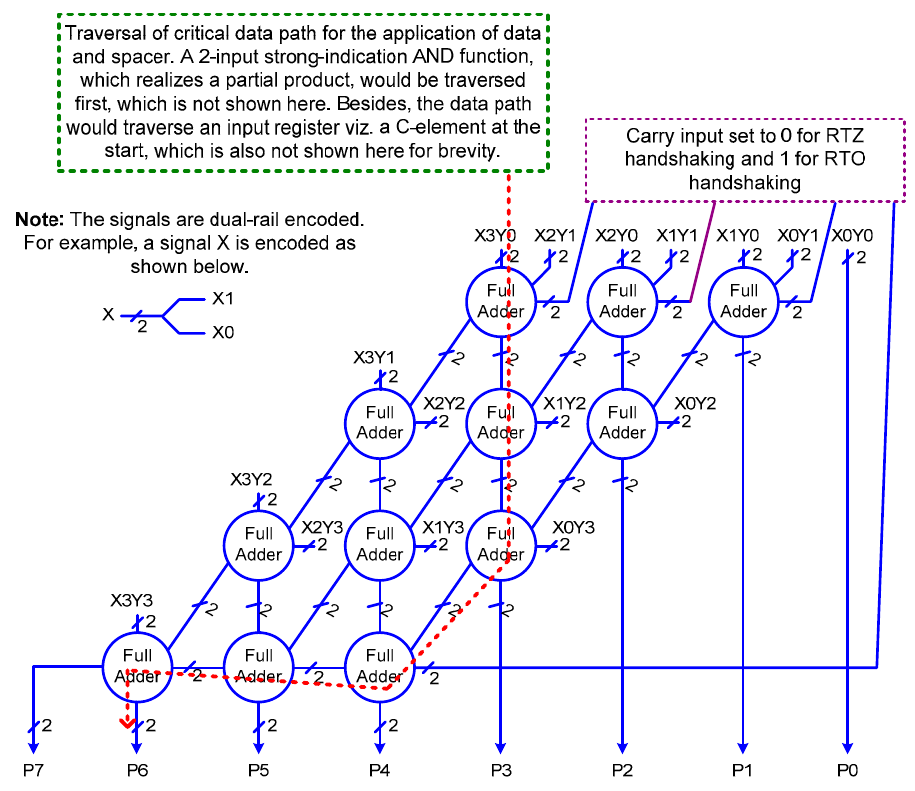
Figure 3. Schematic of the 4 × 4 array multiplier. The critical datapath encountered through the multiplier array for processing the data or the spacer is highlighted by the red dashed line. The notation ‘XjYk’ in Figure 3 represents a partial product.